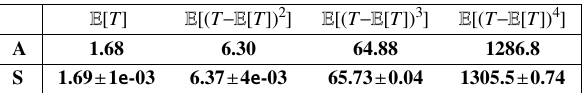
Table 3: Class 1 response time moments from TCP dataset 2.